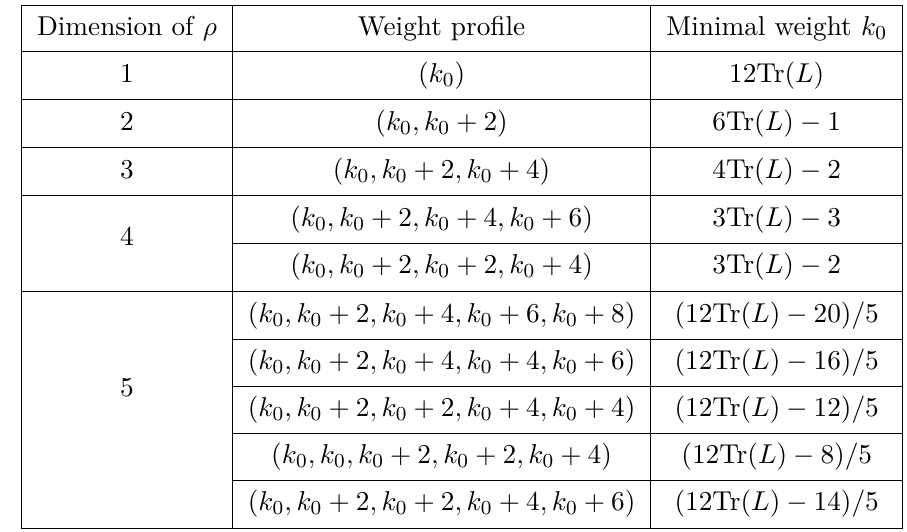
Table 1 . The weight profile and minimal weight of the module M ( ρ ) with dim ρ < 6 , and the pa- rameter L is defined by ρ ( T ) ≡ e 2 πiL which implies L = diag ( r 1 , r 2 , . . . , r d ) . There are two types of irreps at dimension 4 , namely cyclic and non-cyclic, and corresponding to ρ ( S 2 ) = − ( − 1) 3 Tr ( L ) and ρ ( S 2 ) = ( − 1) 3 Tr ( L ) respectively [91]. There are five types of irreps at dimension 5 , corresponding to Tr ( L ) = 5 n + i with i = 0 , 1 , 2 , 3 , 4 and n ∈ Z 12